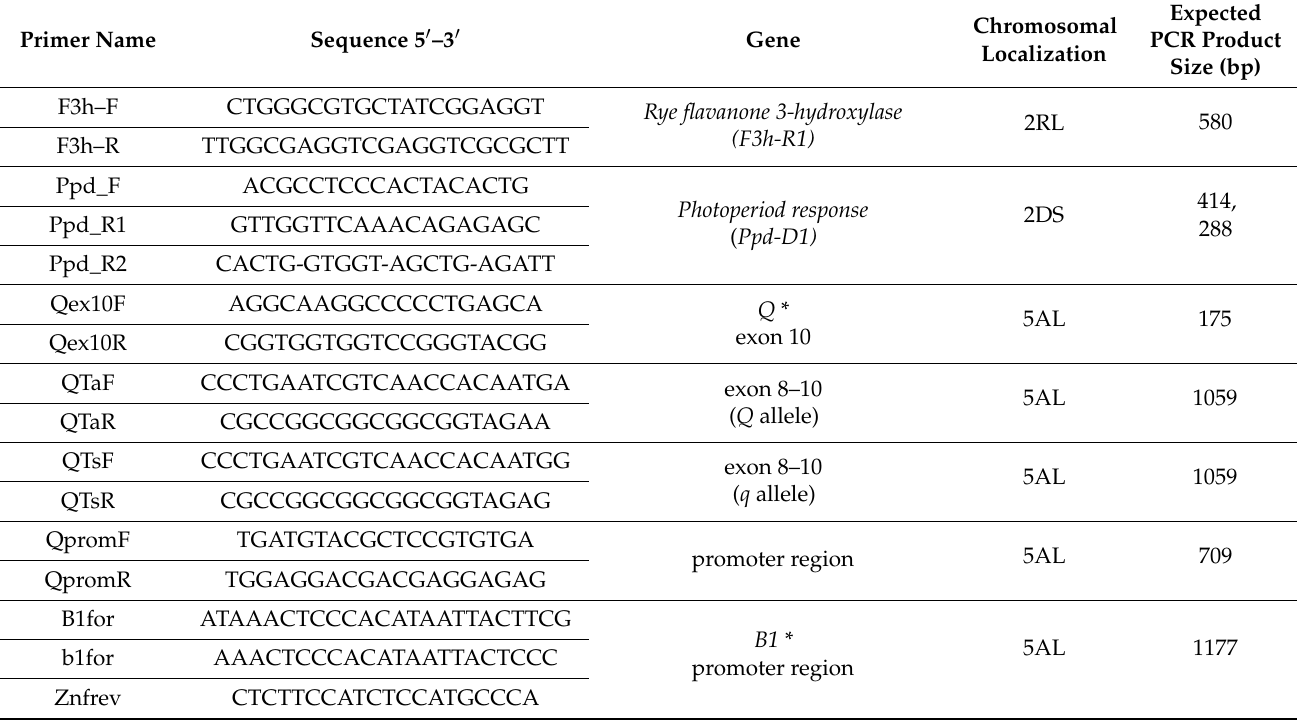
Table 1. Primers used in the work.